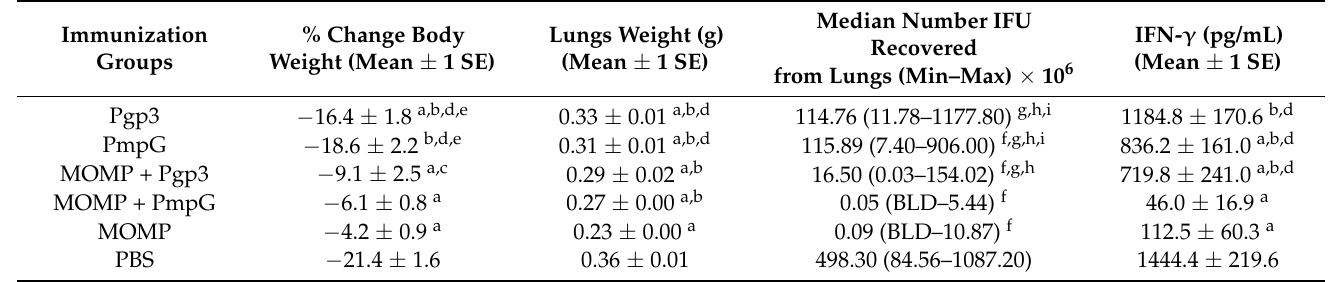
Table 1. Disease burden, yields of C. muridarum IFU, and IFN- γ in the lung’s supernatants at D10 post